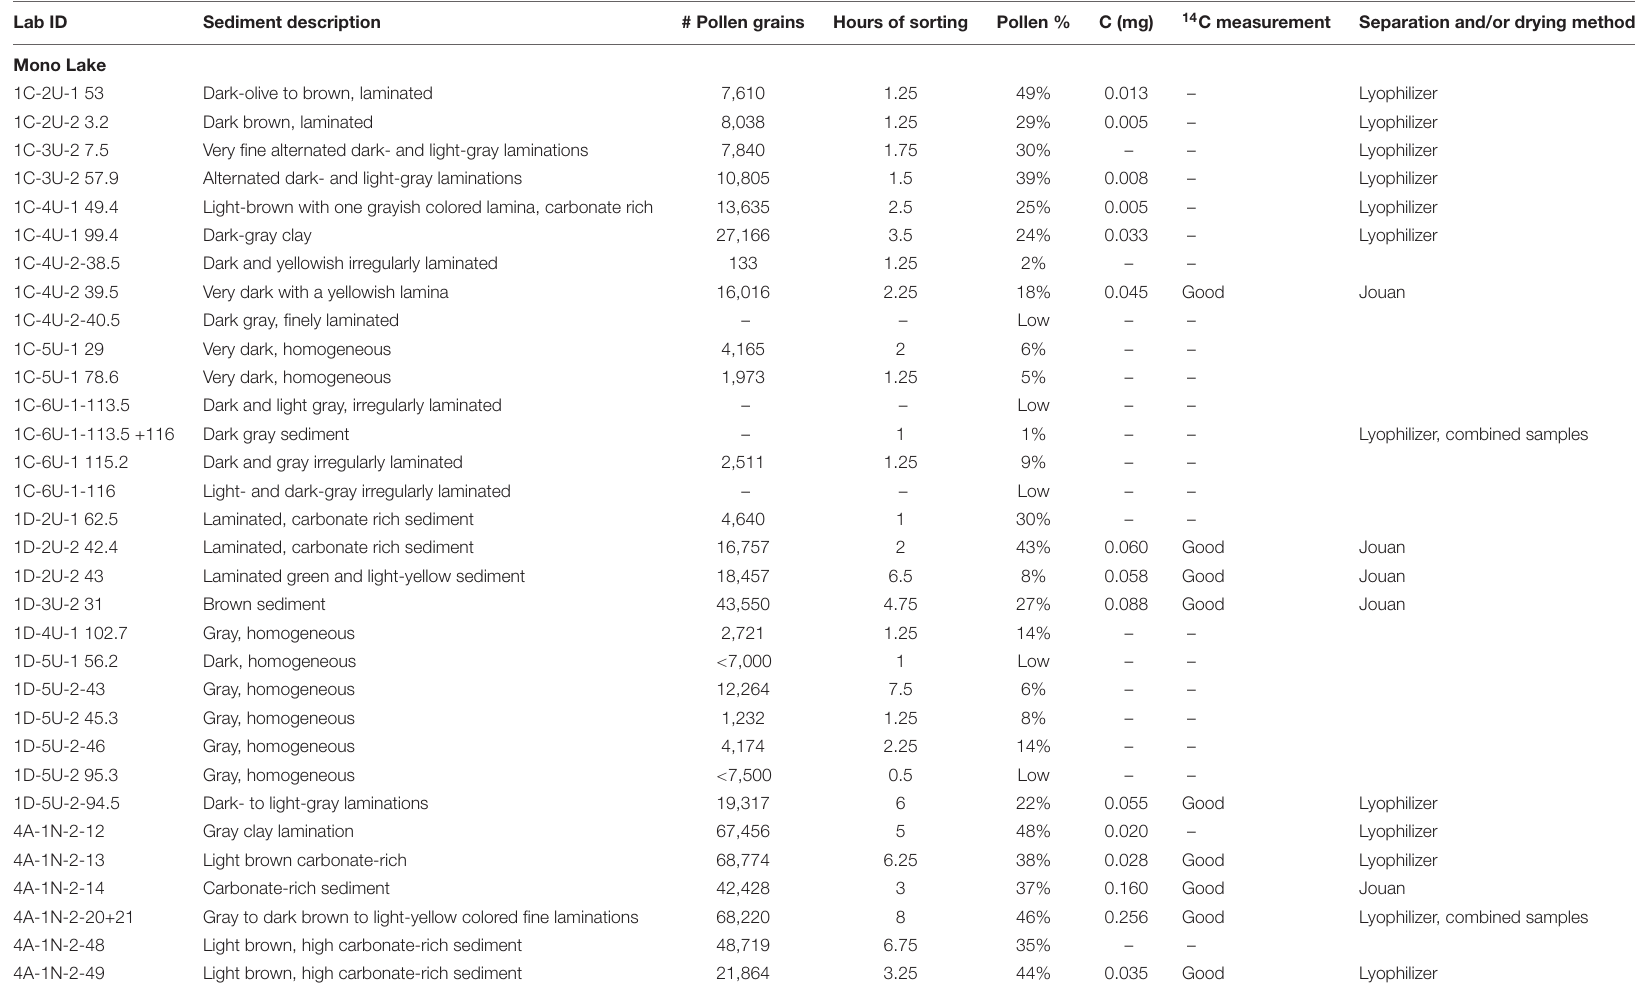
TABLE 1 | Fossil samples from Mono Lake and Fallen Leaf